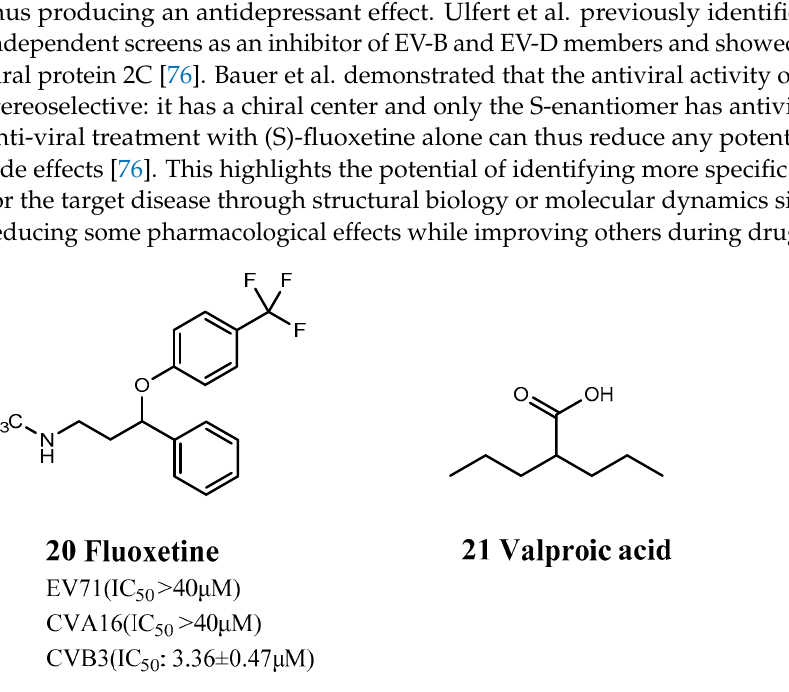
Figure 5. Structures of nervous system